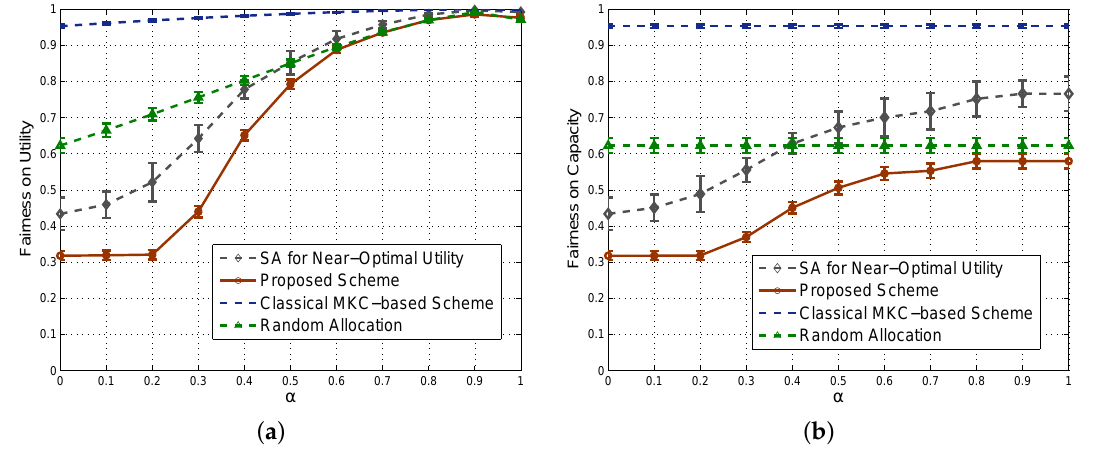
Figure 8. Comparison of fairness: ( a ) based on utility; ( b ) based on